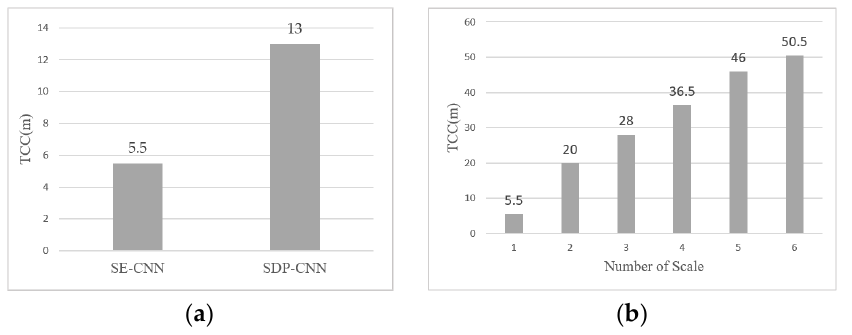
Figure 13. TCC of the SE-SNN and the SDP-CNN ( a ), and the increase in TCC with the change in the number of scales ( b ).